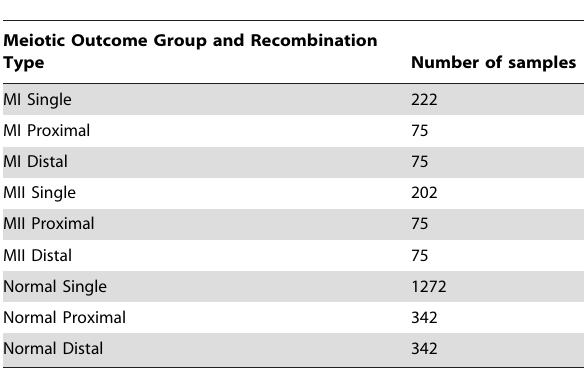
Table 1. Population Sample